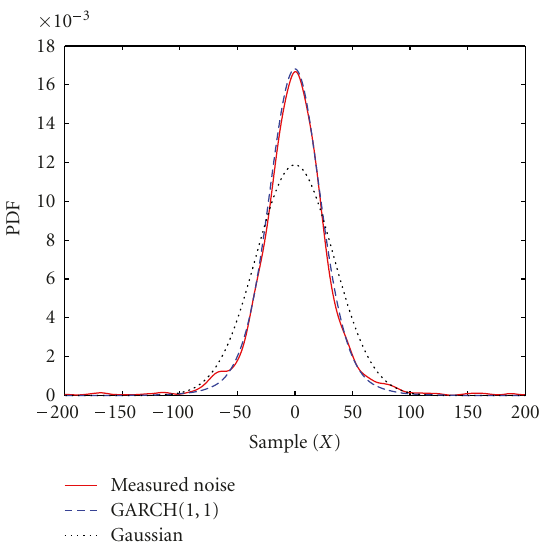
Figure 6: Measured noise, simulated GARCH(1,1), and Gaussian PDF.